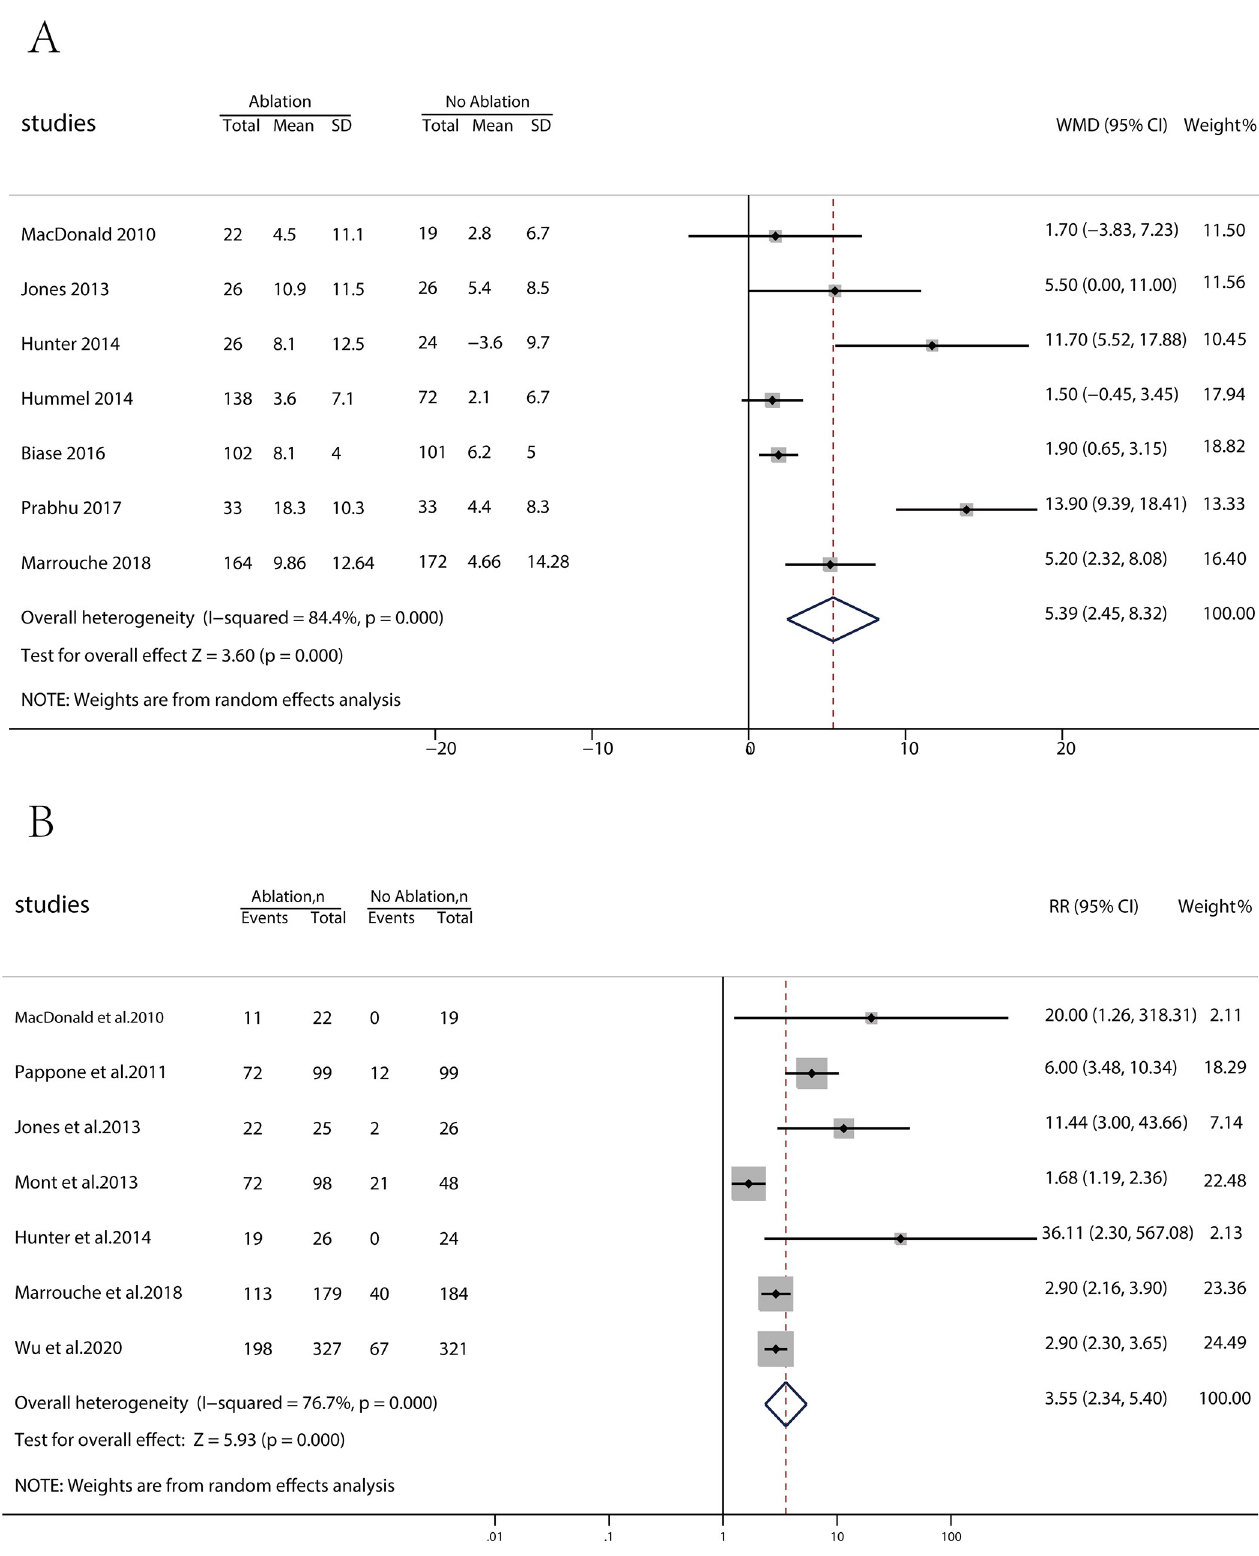
Fig 3. (A) Forest plot displaying weighted mean difference (WMD) for the change in LVEF. (B) Forest plot displaying risk ratio (RR) for the maintenance of sinus rhythm (SR) at the end of follow-up.